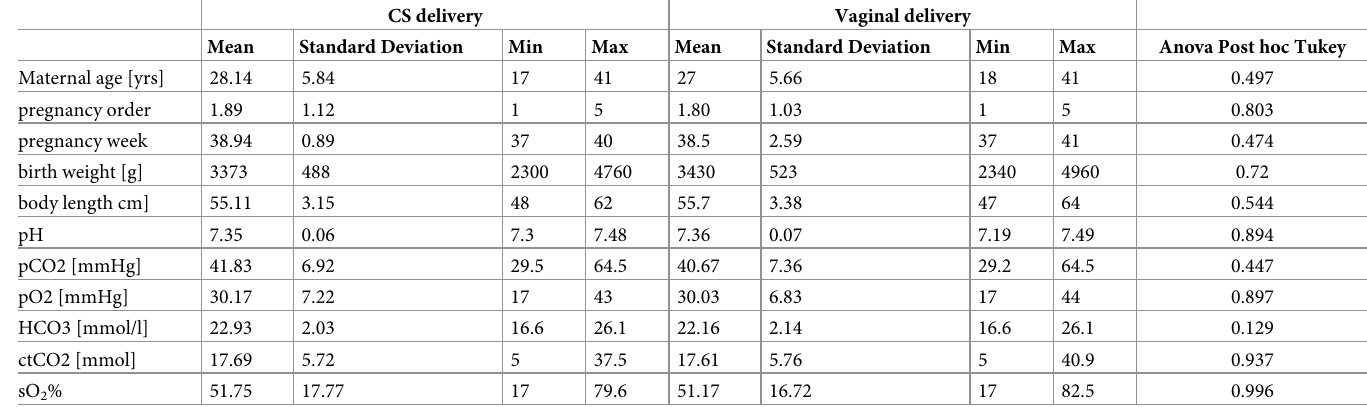
Table 1. Descriptive statistics of the values of maternal and neonatal traits under analysis.